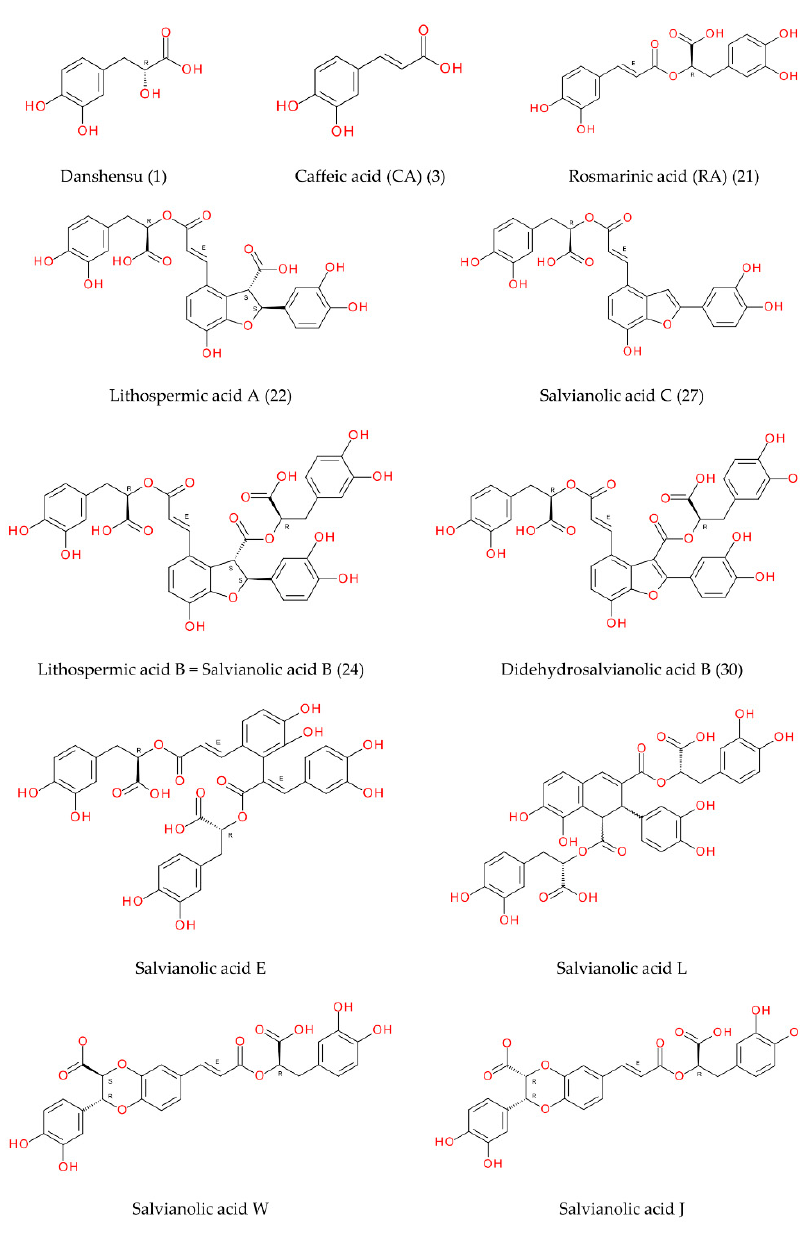
Figure 1. Ca ff eic acid Figure 1. Caffeic acid derivatives.